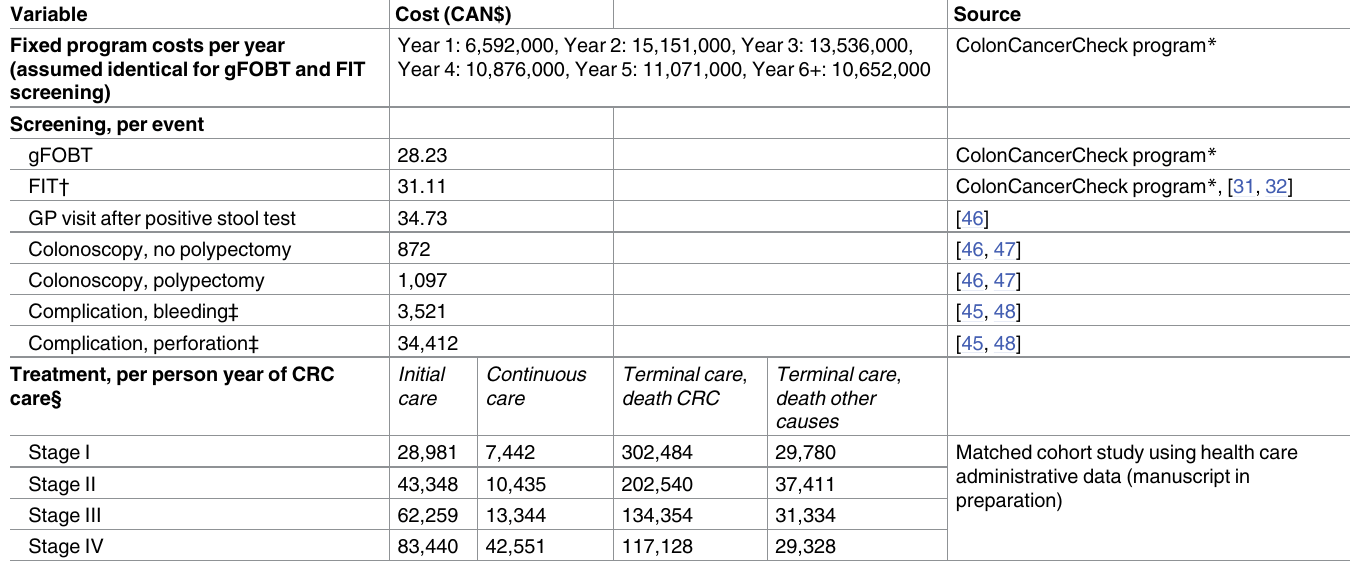
Table 3. Cost estimates used in the model (2013 Canadian